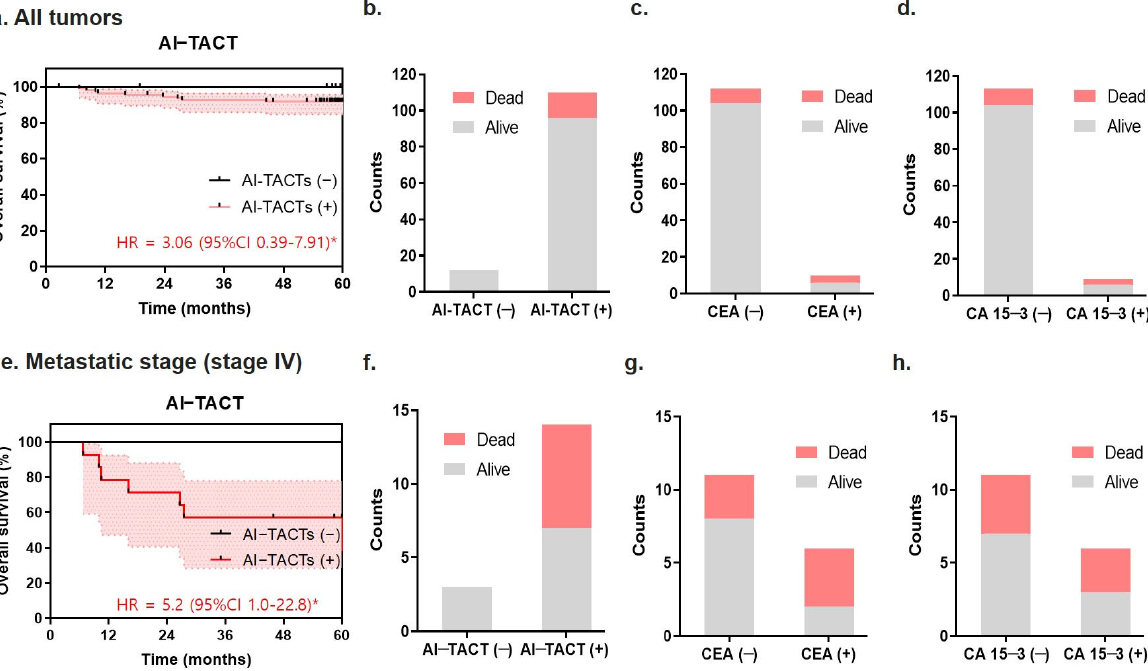
Figure 4. Prognostic value of the TACT assay in breast cancer patients. ( a ) Five-year overall survival of all samples in the test cohort ( n = 122) according to the TACT assay. ( b ) Survival status of patients in the test cohort according to the AI-TACT assay. AI-TACT ( − ) included AI-TACT ( − ) to AI-TACT ( − ) and TACT (+) to AI-TACT ( − ) before and after treatment. AI-TACT (+) included AI-TACT ( − ) to AI-TACT (+) and TACT (+) to AI-TACT (+) before and after treatment. ( c ) Survival status of all samples in the test cohort according to CEA. ( d ) Survival status of all samples in the test cohort according to CA15-3. ( e ) Five-year overall survival of patients with metastatic tumors in the test cohort according to the AI-TACT assay ( n = 17). ( f ) Survival status of patients with metastatic tumors in the test cohort according to the AI-TACT assay. ( g ) Survival status of patients with metastatic tumors in the test cohort according to CEA. ( h ) Survival status of patients with metastatic tumors in the test cohort according to CA15-3. Log-rank test. * p <